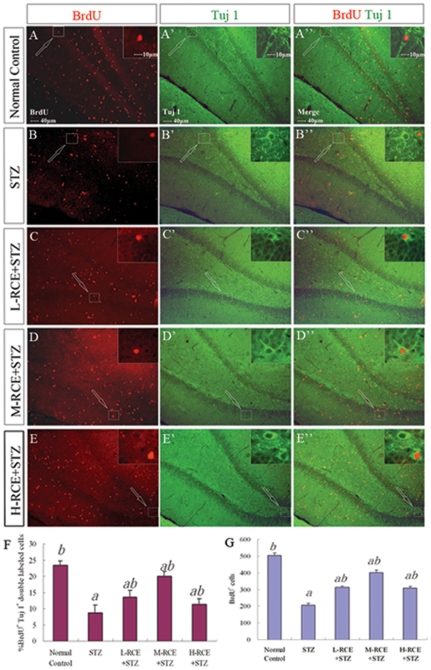
BrdU/Tuj1 double immunofluorescence labeling in the rat hippocampus.(A–E, A′–E′, A″–E″) Representative photomicrographs of BrdU (red fluorescence in the nuclei, A–E) and Tuj1 labeling (green fluorescence in the cytoplasm, A′–E′; A″–E″ are merged images of BrdU and Tuj1 labeling) from different experimental groups: (A–A″) Normal control group, (B–B″) streptozotocin-treated (STZ) group, (C–C″) Low dose of RCE pre-treatment followed by STZ treatment group (L-RCE+STZ), (D–D″) Medium dose of RCE pre-treatment followed by STZ treatment group (M-RCE+STZ) and (E–E″) High dose of RCE pre-treatment followed by STZ treatment group (H-RCE+STZ). The upper right inset of the photomicrograph is the enlarged view of a double-labeled cell in the boxed area (arrow). (F) Bar chart showing the percentages of differentiating neurons (BrdU+Tuj1+/BrdU+×100%). (G) Bar chart showing BrdU-positive cell counts. Values are expressed as mean±SD. a: p<0.05 compared with the normal control group; b: p<0.05 compared with the STZ group.